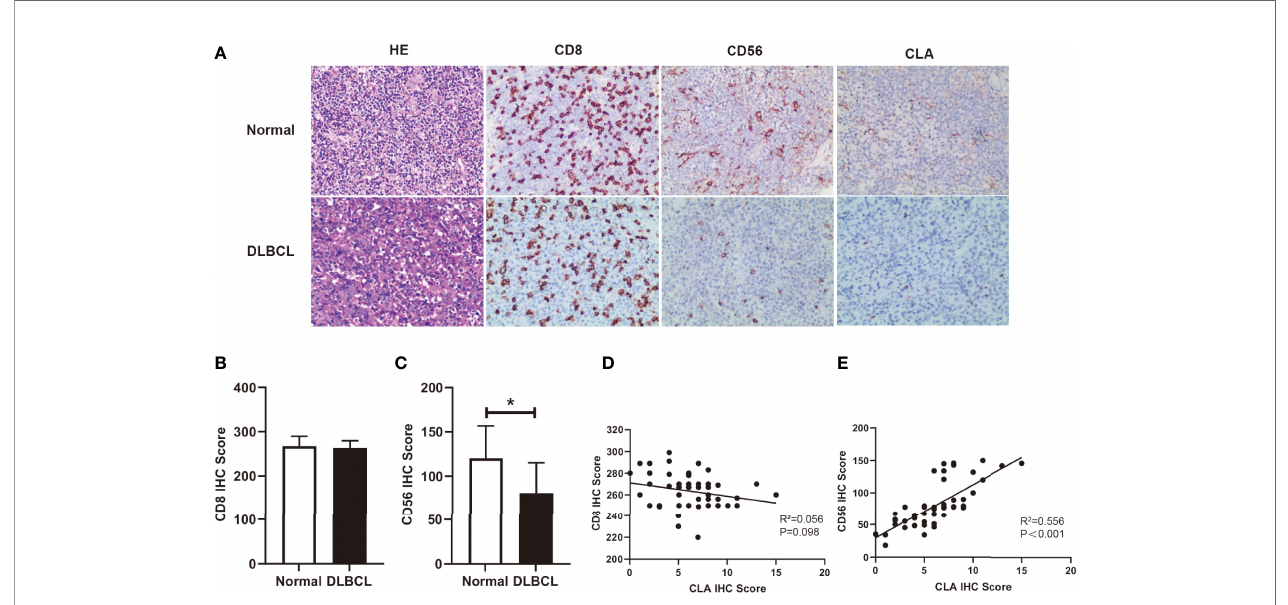
FIGURE 2 | Fucosylation was relevant to in fi ltration of NK cells in DLBCL. (A) Representative images of morphology with H&E staining and immunohistochemical staining of CD8, CD56, and CLA between normal and DLBCL cases (magni fi cation×200). (B, C) Statistics were based on the expression of CD8 + T cells and CD56 + NK cells in DLBCL(n = 50) and normal lymph node (n = 4) biopsies per fi eld of each group. (D) Correlations of CLA positive cells and CD8 + T cells in DLBCL ( p = 0.098, r 2 = 0.056, n = 50) (E) Correlations of CLA positive cells and CD56 + NK cells in DLBCL ( p < 0.001, r 2 = 0.56, n = 50). Data are presented as mean ± SD. * p <